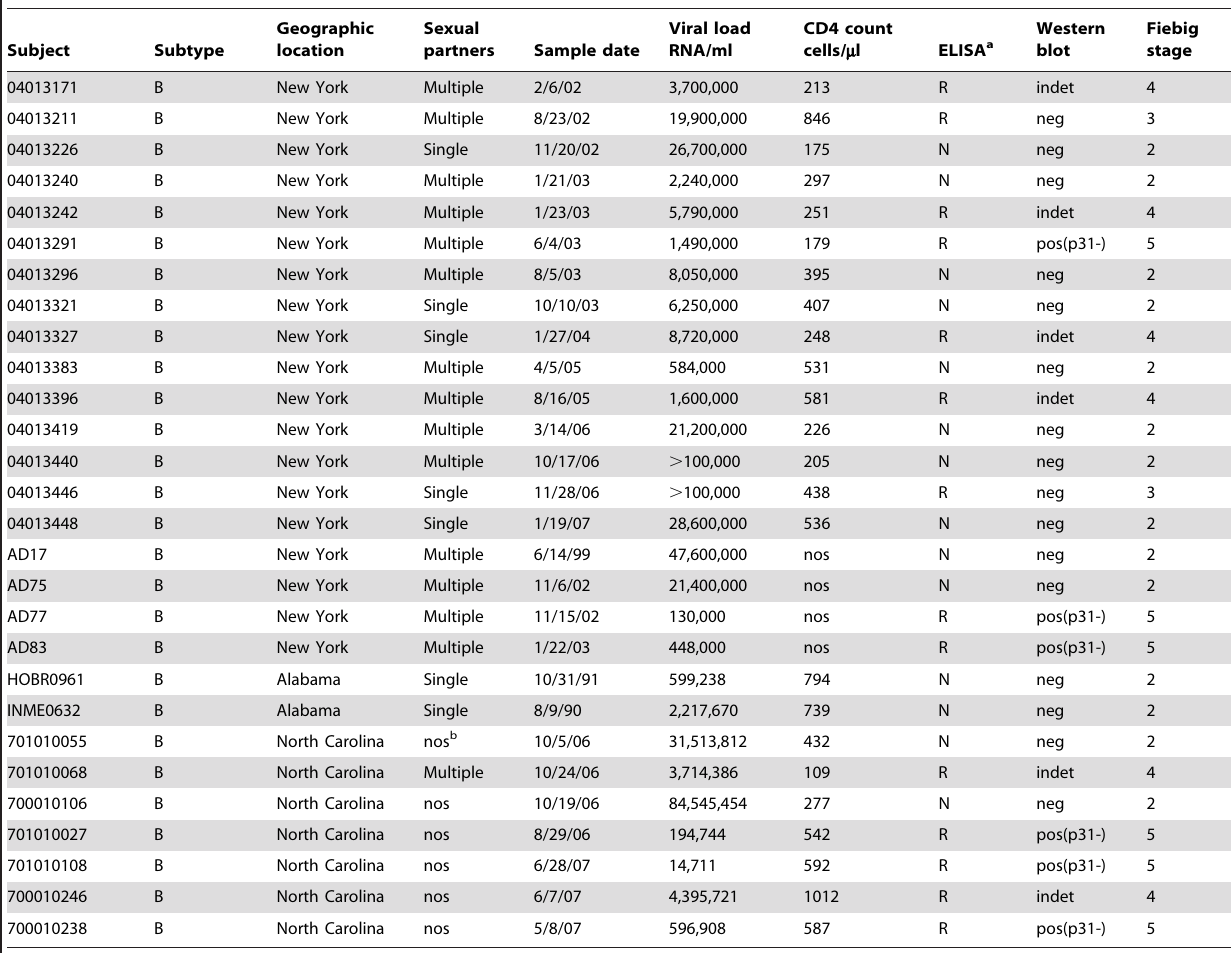
Table 1. Demographics, risk group and baseline laboratory